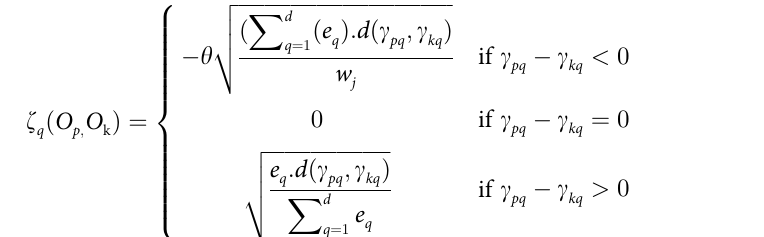
The specific steps and results of the classical TODIM are shown as follows. Step 1. We can calculate the weighting vector of attributes e matrix shown in Table 7 using the same method. Step 2. Determine the dominance degree using Eq (23), and the result is shown in Tables 24–28.